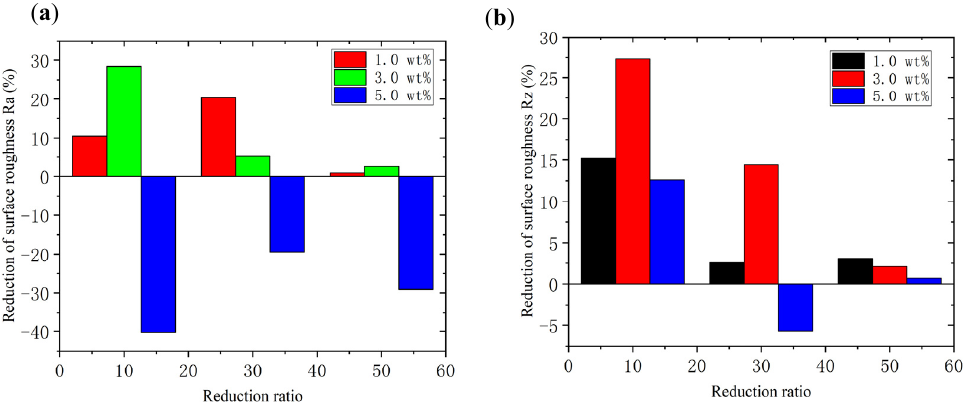
Figure 10. Reduction in the surface roughness of the rolled copper foils under different reduction ratios: ( a ) Ra and ( b ) Rz.